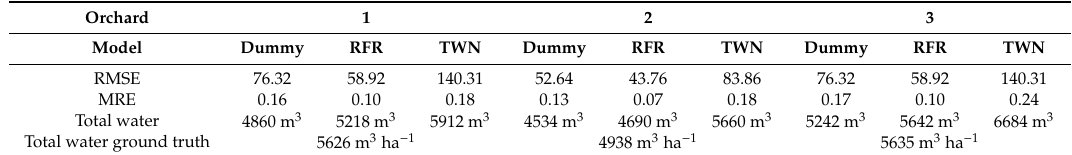
Figure 5. Monthly estimated water requirement for the year 2018: ( a ) Orchard 1; ( b ) Orchard 2; ( c ) Orchard 3. Table 4. Estimated water requirement (m 3 ha − 1 ) during 2018 for each model and orchard. TWN: total water needs.